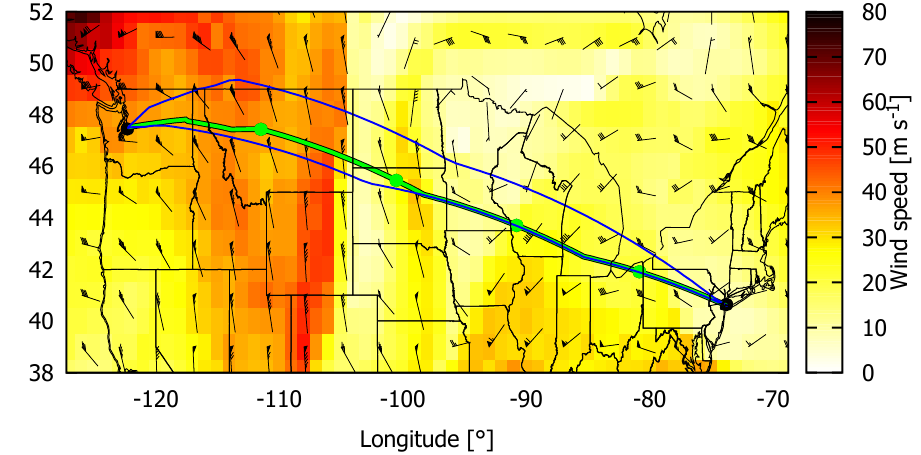
Figure 11. In-flight re-optimized trajectories on 31st January 2020, where the green trajectory is restricted to the CoO hull, while the black trajectory is freely optimized. In-flight re-optimizations are calculated at 1:00 a.m., 2:00 a.m., 3:00 a.m., and 4:00 a.m. UTC.